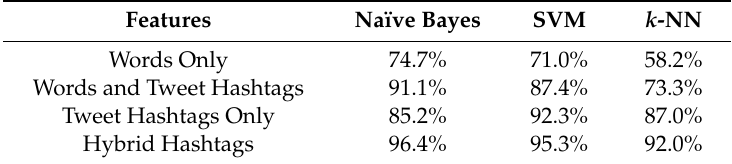
Table 3. Comparison of HHTC-Batch Tweet topic classification results with di ff erent sets of features.